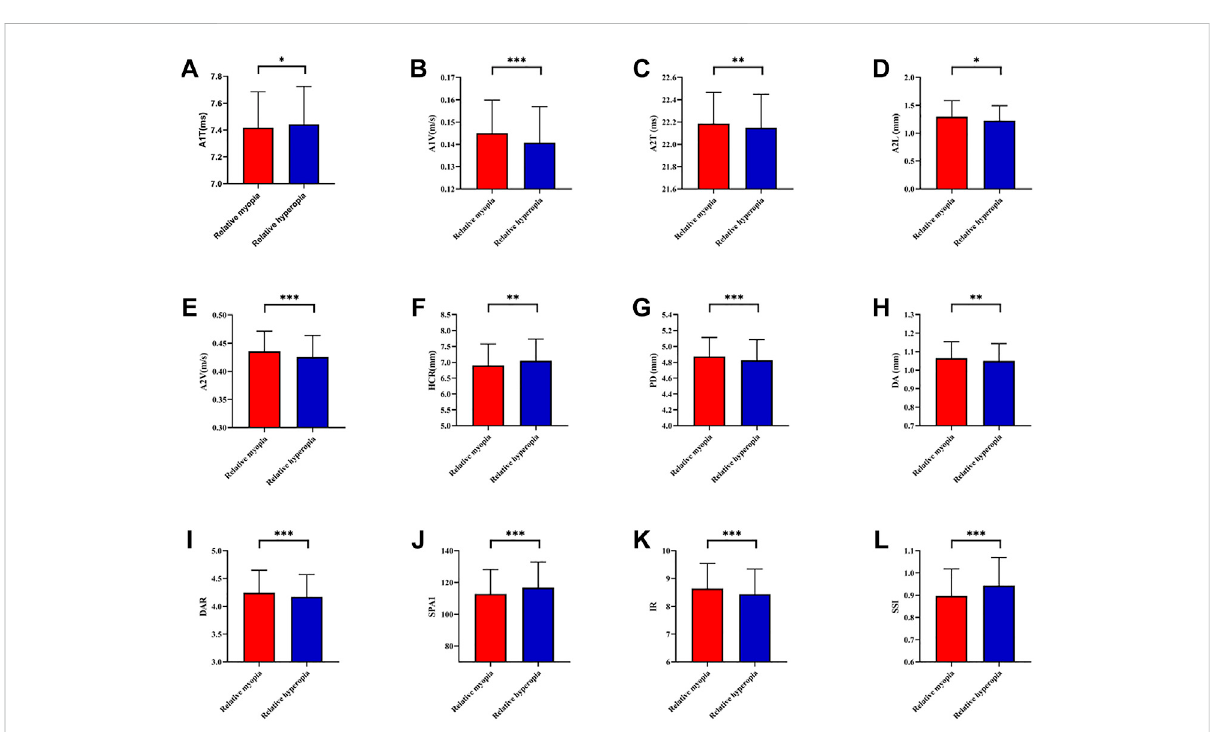
FIGURE 3 Histogram comparison of A1T, A1V, A2T, A2L, A2V, HCR, PD, DA, DAR, SPA1, IR, and SSI (A – L) in anisometropia fellow eyes. *means p < 0.05, **means p < 0.01 ***means p <